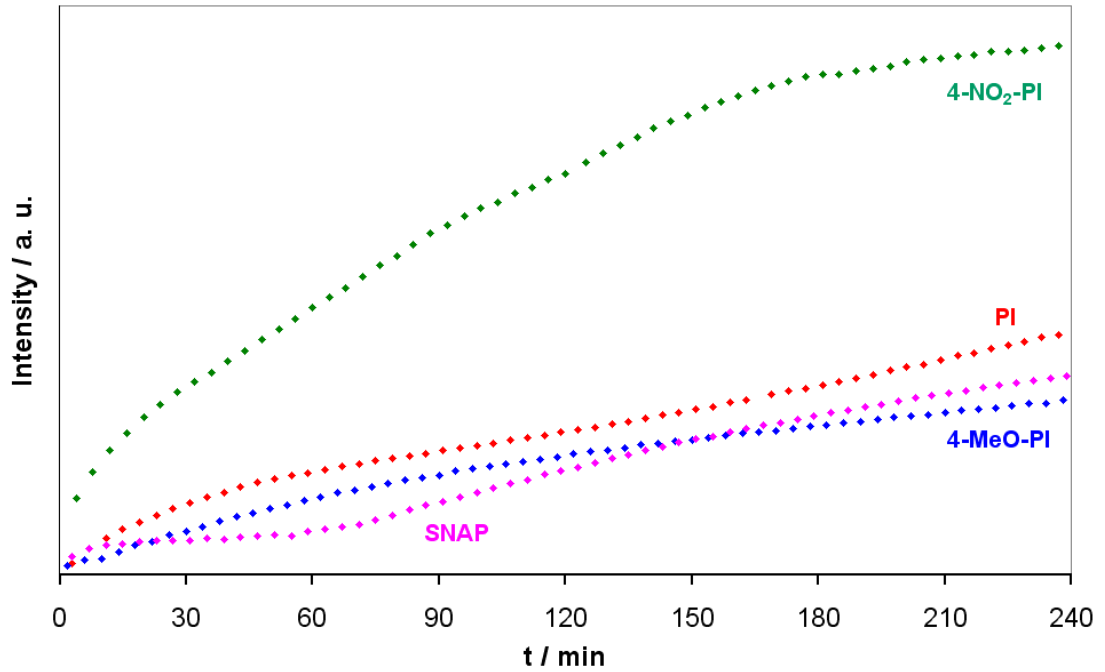
Figure 4. Normalized EPR intensity of the species Fe(MGD) 2 (NO) (measured in arbitrary units) as a function of time for: S-nitroso- N -acetylpenicillamine (SNAP), N -hydroxy-4-methoxy benzenesulfonamide (4-MeO-PI), Piloty’s acid (PI) and N -hydroxy-4-nitrobenzenesulfonamide (4-NO 2 -PI). The concentration of all NO-donors was 0.6 mM. The intensity, obtained after double integration of the spectra, was measured in PBS at 37 °C and pH 7.4. All spectra were recorded with the same instrumental parameters.